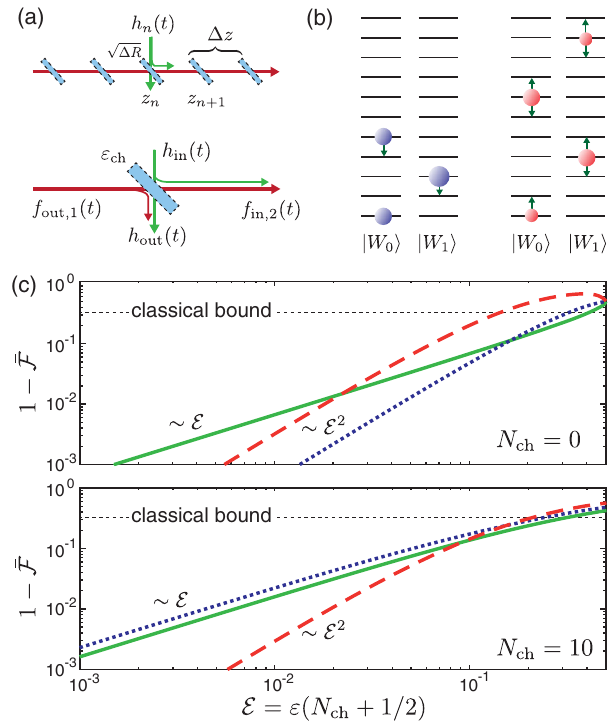
FIG. 4. (a) Channel losses are modeled by a series of beam splitters with reflectance Δ R ¼ Δ z=L . For a homogeneous ab waveguide, the total loss can be taken into account by mixing the outgoing field of node 1 with a thermal field h on a beam splitter in 1 − e − L=L ab . (b) Illustration of the code with reflectance ε ch ¼ words j W σ i used for correcting single-photon loss errors (left) and for correcting single-photon loss and single-photon absorp- tion errors (right). (c) The average transfer fidelity is shown for a state transfer protocol without error correction (green solid line), for the case when single-photon losses are corrected (blue dotted line), and for the case when both single-photon loss and single- photon absorption errors are corrected (red dashed